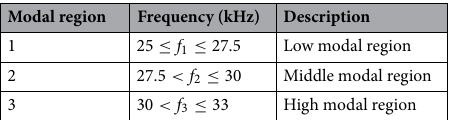
Table 1. Three modal regions of needle constructs L, and AX1–3.